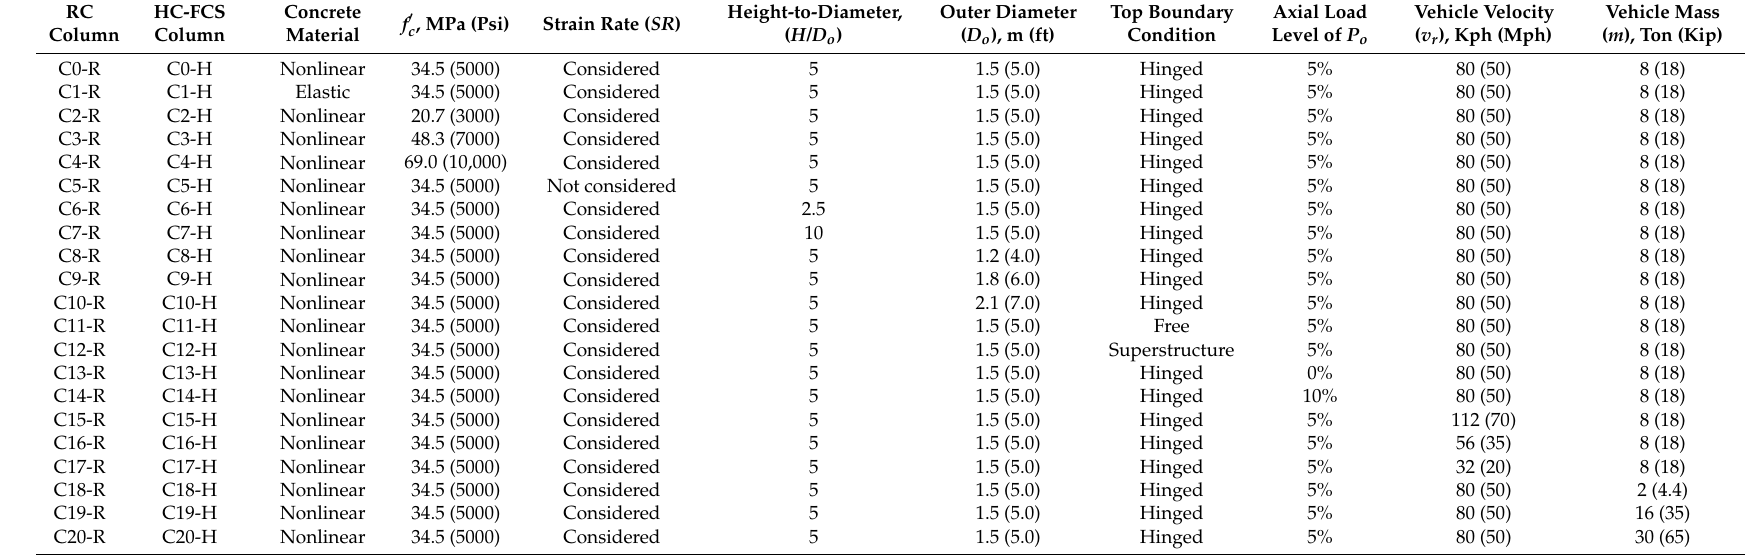
Table 1. Summary of the examined columns’